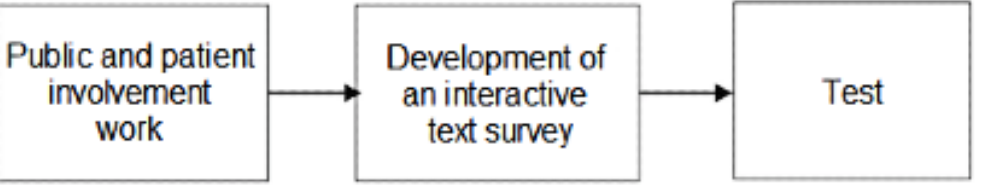
Figure 1. Stepped approach for developing the